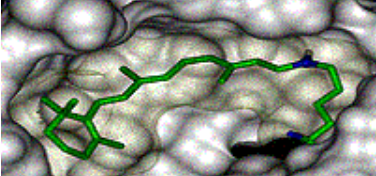
FIGURE 1 . The structure of 11- cis -retinal and in the binding pocket of bovine opsin. The starting model was the PDB entry 1F88. Addition of hydrogen atoms and all optimizations were done in Insight II (InsightII release 98.0 [1998], Molecular Simulations Inc, San Diego, CA). The protonation state of amino acid side chains was obtained using standard pK 7.0. For molecular dynamics runs with FDiscover (Discover ver. 2.98, Molecular Simulations Inc., San Diego, CA).(The figure was generated by Dr. S.